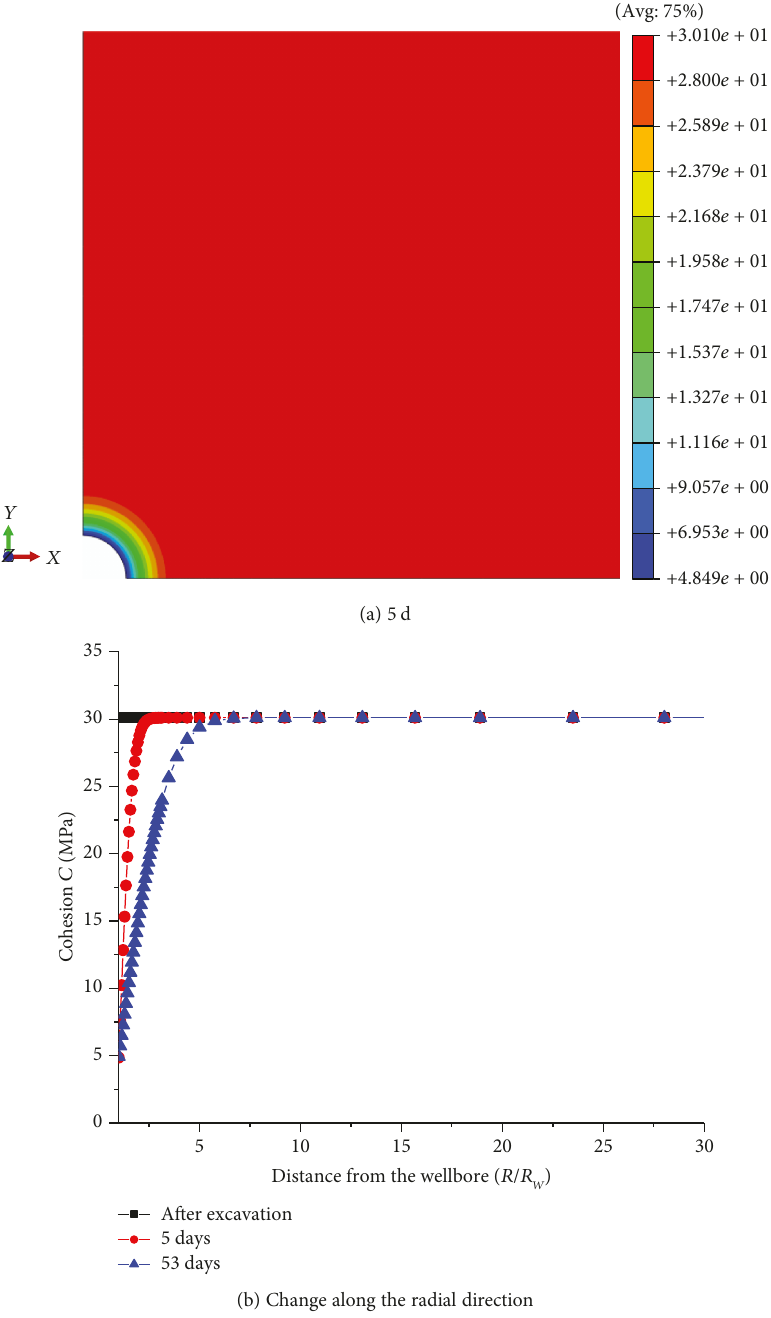
Figure 12: Variation of formation cohesion after